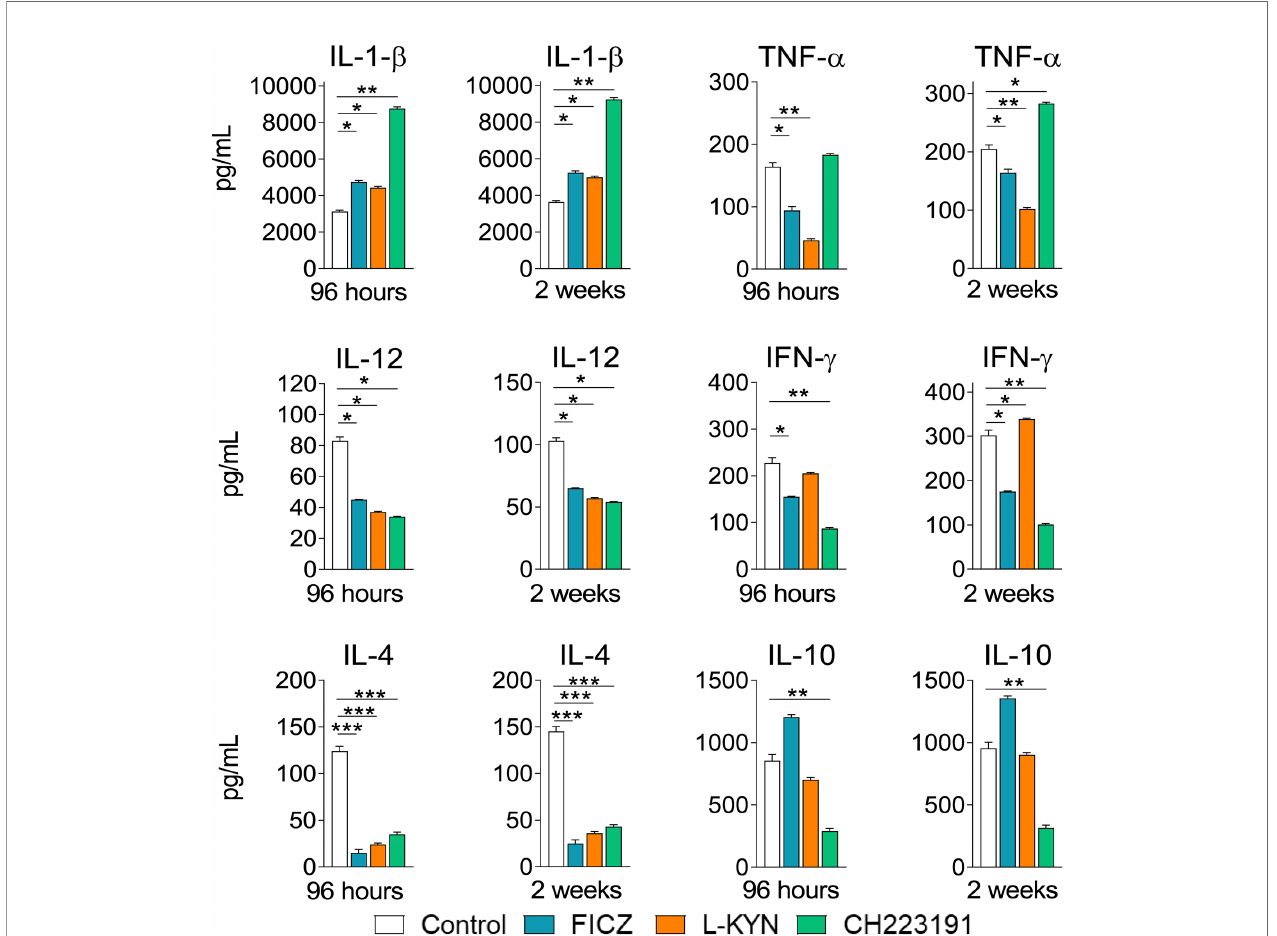
FIGURE 7 | Treatment with AhR ligands increases the levels of pulmonary IL-1 b but reduces the levels of cytokines involved in the development or activity of Th1 and Th2 cells. C57BL/6 mice (n = 5) were infected with 1 x 10 6 P. brasiliensis yeasts and treated with FICZ, L-Kyn, CH223191 as previously described. Control mice were treated with PBS. The animals were sacri fi ced 96 hours and 2 weeks after infection, their lungs removed, macerated and the supernatants analyzed for the presence of cytokines by ELISA. The experiment was repeated twice, and data are expressed as M ± SD. P values < 0.05 were considered signi fi cant (* p < 0.05; ** p < 0.005 and *** p <